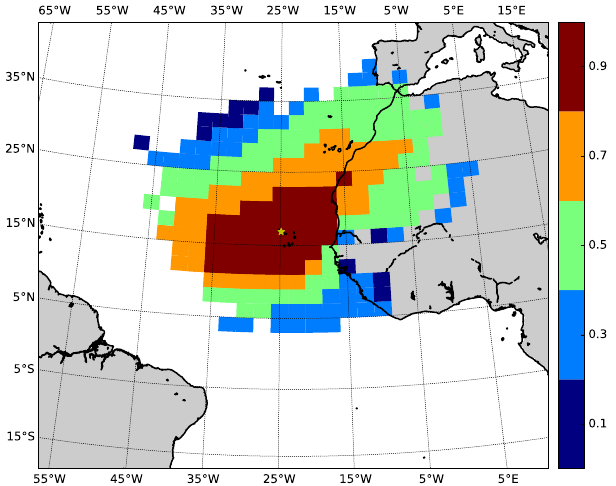
Figure 1. Example of the site footprint for the Cape Verde Ob- servatory (yellow star; 16 ◦ 51 (cid:48) 49 (cid:48)(cid:48) N, 24 ◦ 52 (cid:48) 2 (cid:48)(cid:48) W) derived using thresholds of R = 0 . 1 to 0.9 in the spatial correlation of monthly anomalies in surface ozone from the GEOS-Chem model.